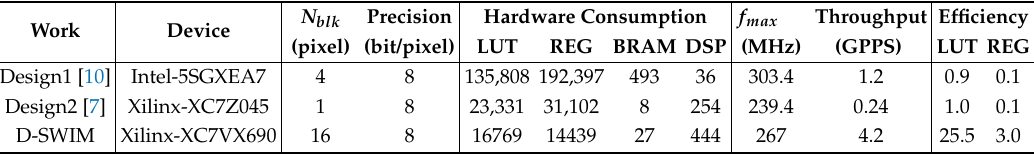
Table 6. Hardware resource consumption and throughput in HC detector